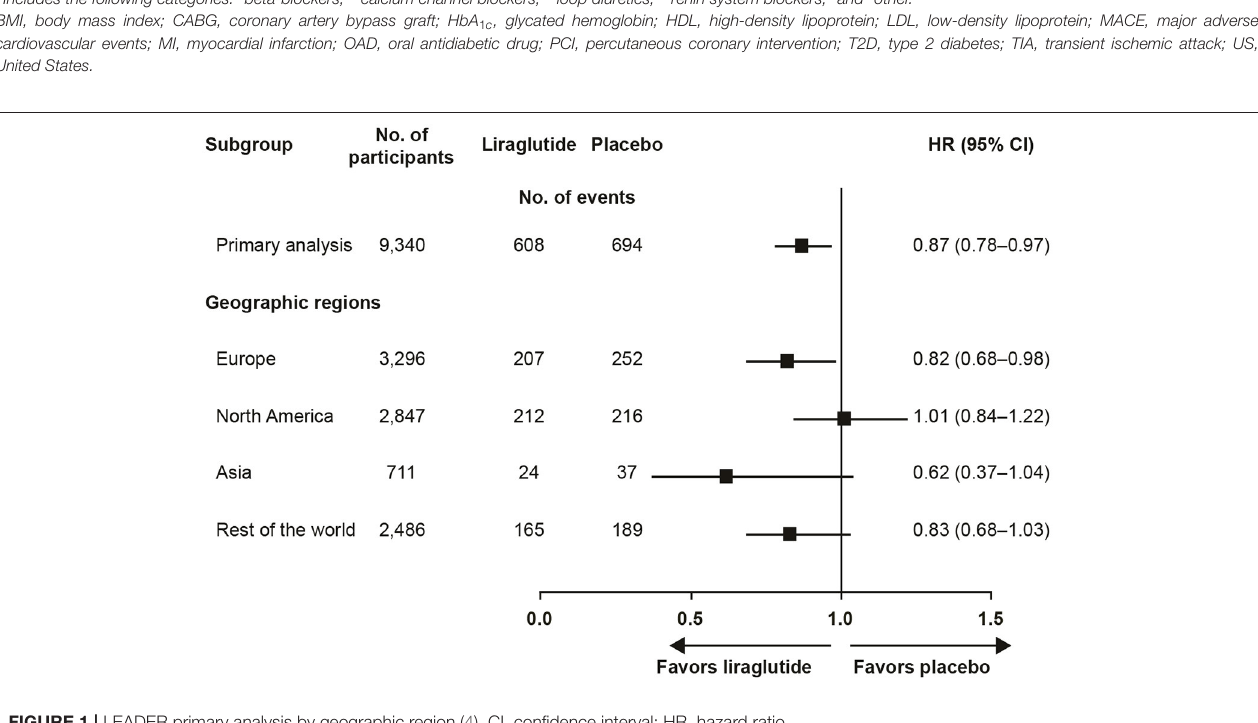
FIGURE 1 | LEADER primary analysis by geographic region (4). CI, confidence interval; HR, hazard